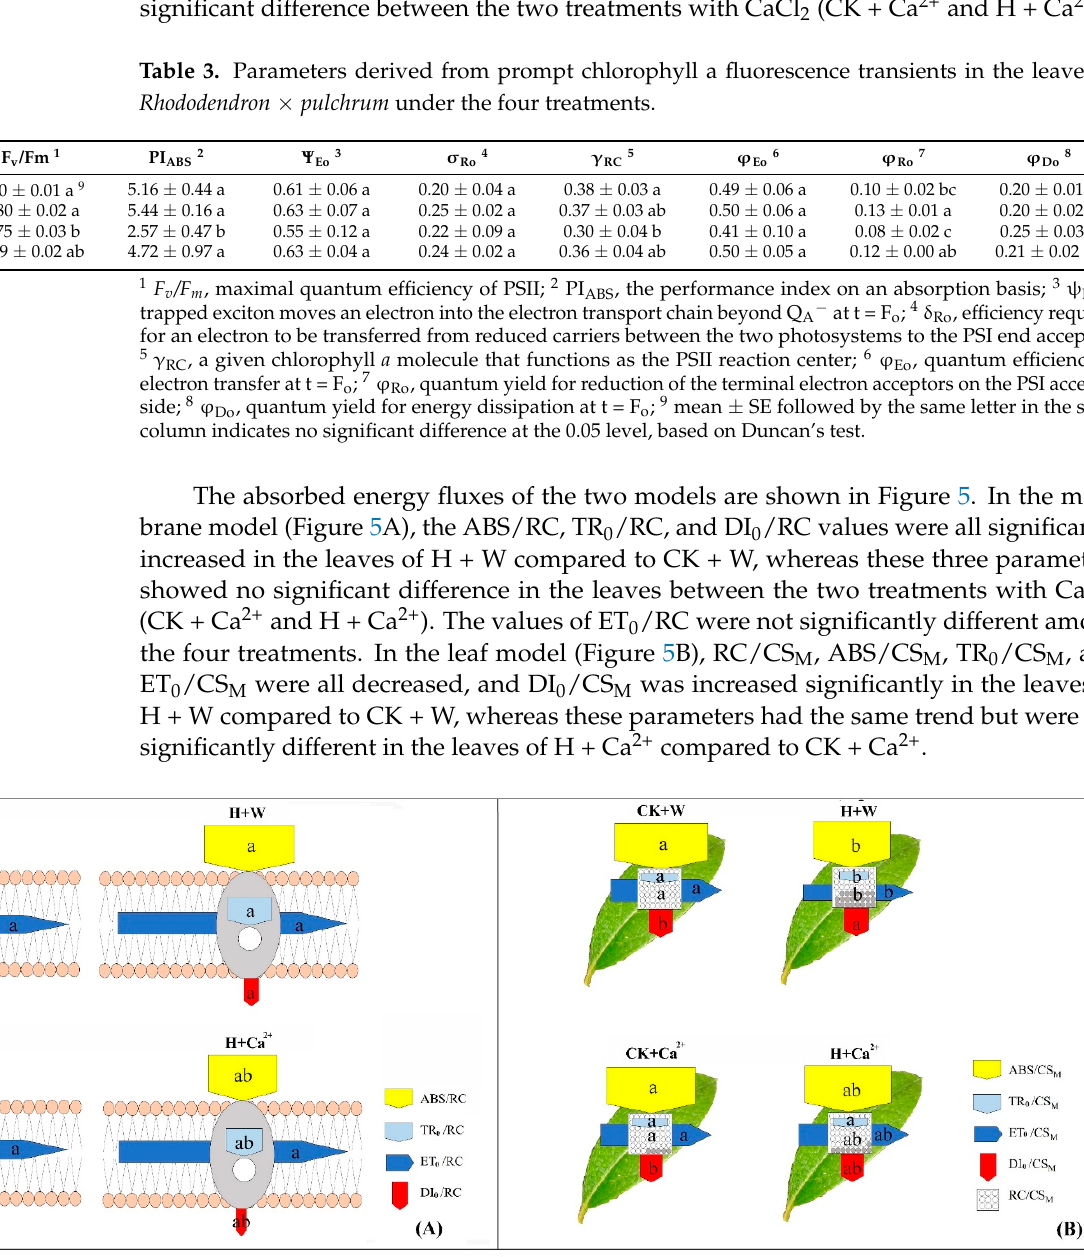
Figure 5. Energy flux models in photosystem II for the leaf samples of Rhododendron × pulchrum under four treatments. The relative value of each parameter is proportional to the width of the arrows. ( A ) Membrane model represents the specific activity on a single RC basis. The average size of the antenna is represented by the ABS/RC parameter. The fluxes of absorbed energy that were trapped by nonreducing PSII centers are shown as diagonally hatched areas in ABS/RC and TR/RC contours. ( B ) Leaf model represents the phenomenological parameters normalized per unit cross-section (CS) of a photosynthesizing object. The Q A -nonreducing reaction centers are shown with black circles, and the Q A -reducing active centers are depicted with white circles. These were determined at minimum (index 0) or maximum (index m) levels of chlorophyll fluorescence; for example, ET 0 or ET m . The fluxes presented in the scheme were normalized to the maximal fluorescence level (m). The same letters indicate no significant difference at the 0.05 level based on Duncan’s